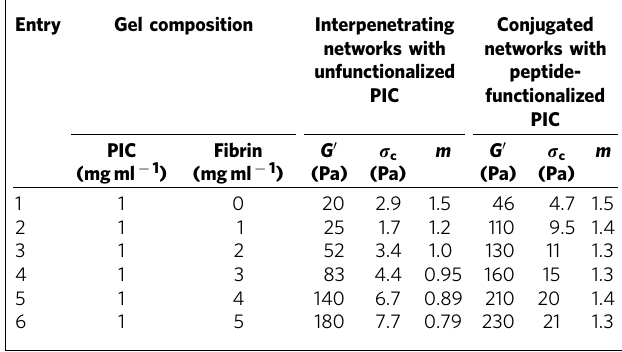
Table 1 | Mechanical properties of conjugated and unconjugated PIC/fibrin hybrid hydrogels at different component